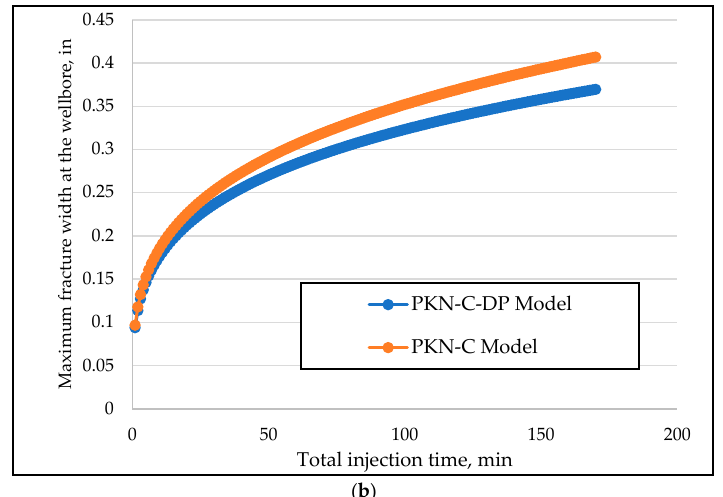
Figure 5. ( a ) Average fracture width versus total injection time for PKN-C and PKN-C-DP models; ( b ) maximum fracture width at the wellbore versus total injection time for PKN-C and PKN-C-DP models.